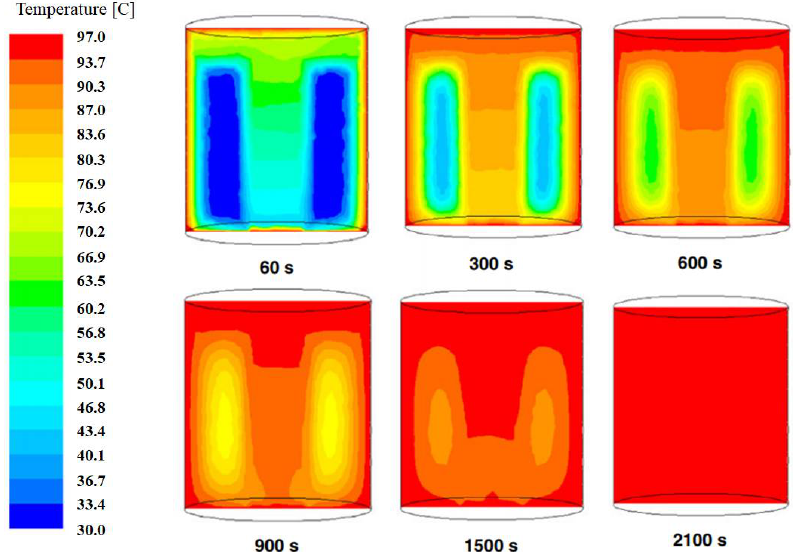
Figure 3. Temperature contours of the canned pineapple slices in sugar solution, reproduced with permission from [74]; published by Springer Nature, 2013.